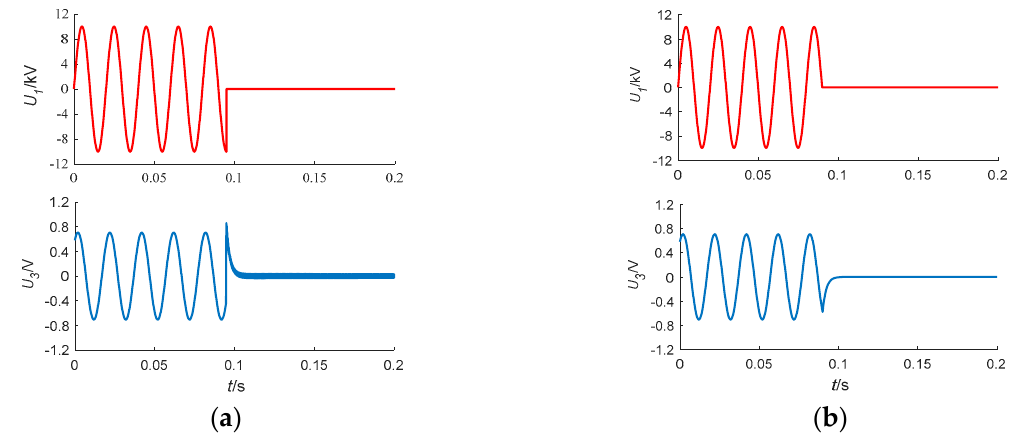
Figure 7. ( a ) Transient characteristics of short circuit at peak time and ( b ) Transient characteristics of short circuit at zero-crossing time.